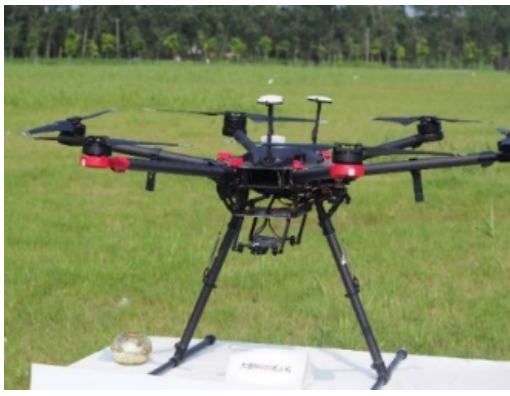
Figure 2. DJI “Yu” series MAVIC2 aircraft.